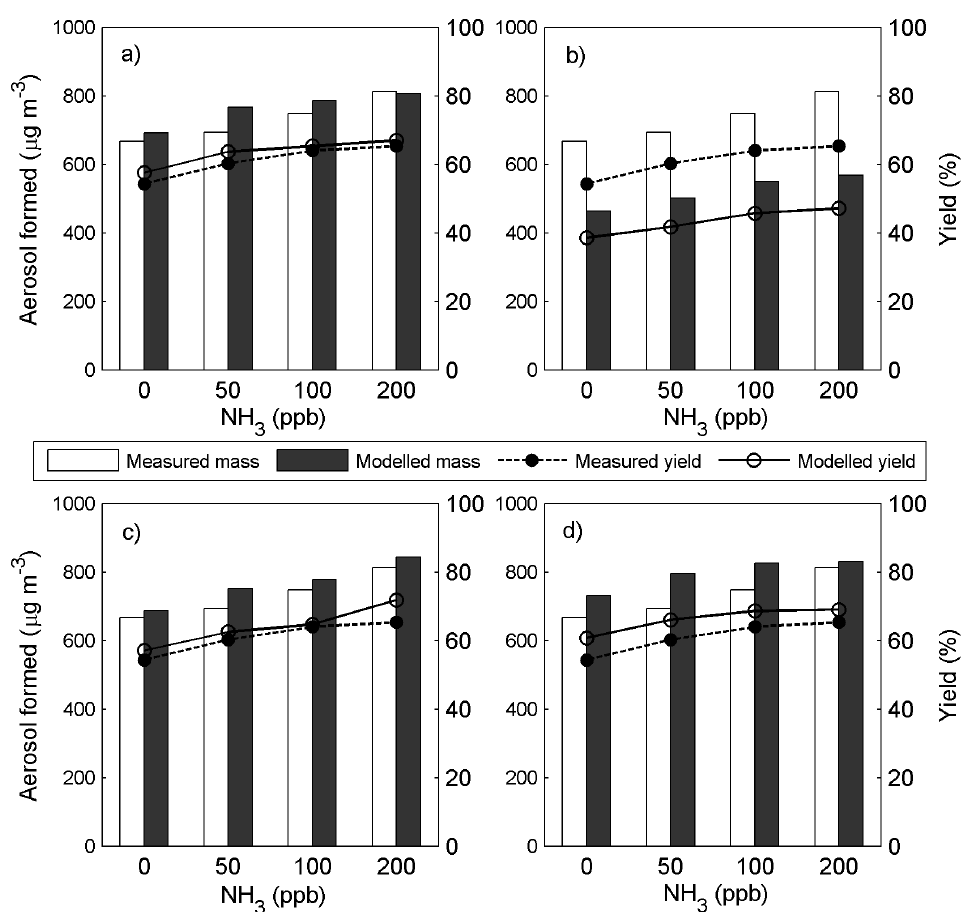
Figure 9. Comparison of modelled and measured SOA mass and mass yields at different initial levels of NH 3 (g). In (a) the model results are from simulations with vapour pressures from SIMPOL, activity coefficients from AIOMFAC and very slow mixing between the particle layers (base case); in (b) the results are from simulations with vapour pressures from Nannoolal et al. (2008), activity coefficients from AIOMFAC and very slow mixing between particle layers; in (c) the results are from simulations with vapour pressures from SIMPOL, unity activity coefficients (ideal solution) and very slow mixing between the particle layers; and in (d) the model results are from simulations with vapour pressures from SIMPOL, activity coefficients from AIOMFAC and semi-solid less viscous particles with D 0 , monomer , SOA = 10 − 15 cm 2 s − 1